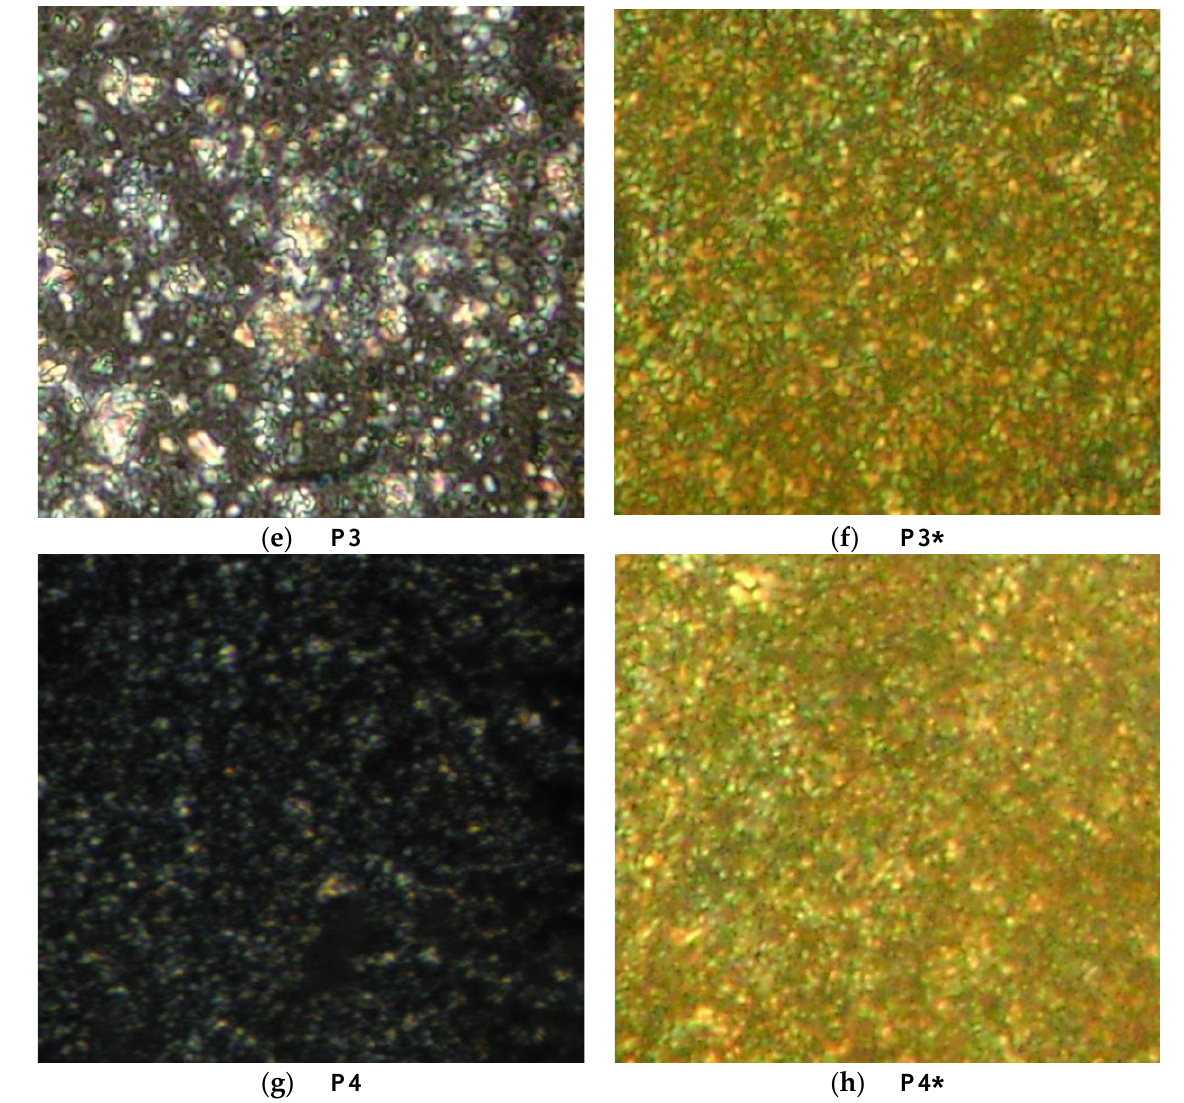
Figure 2. Representative POM images of the treated ( a – d ) and untreated ( e – h ) thin films. POM images were acquired using the 40 × objective, and the eyepiece had 10 × magnification, giving a theoretical magnification of 400 ×